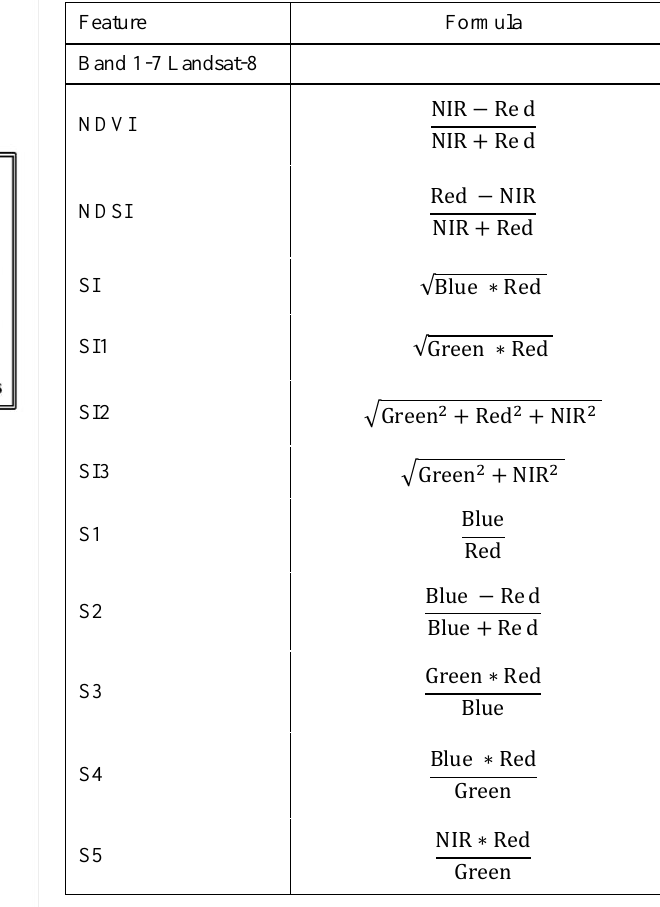
Table 2 . Features extracted from Landsat-8, including seven bands of Landsat-8 OLI, vegetation, and salinity